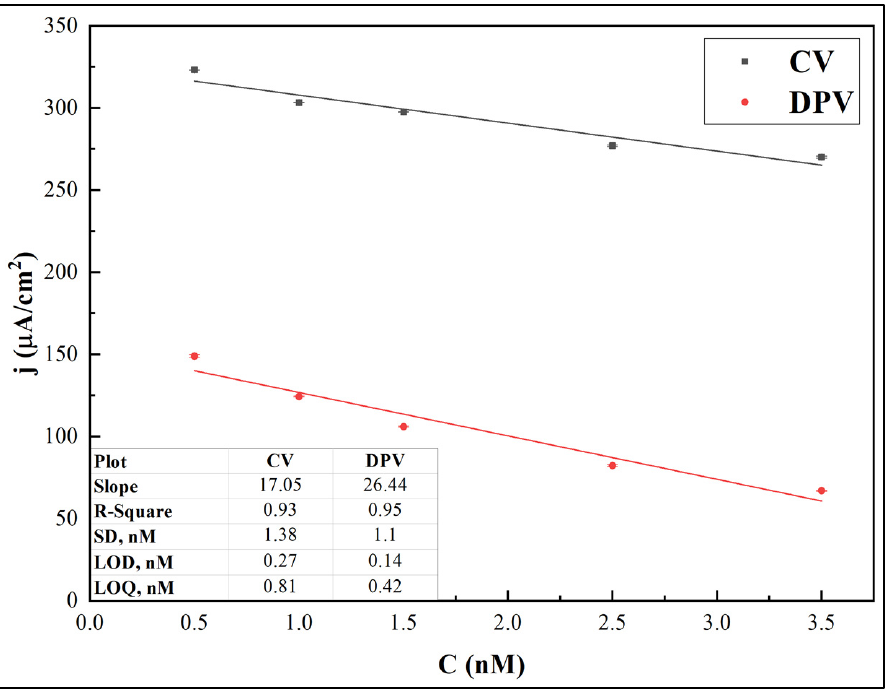
Figure 9. Calibration curves for j pa and j p obtained from CV and DPV peak values, respectively, vs. anti-rSpike antibody concentration. Error bars are calculated as a percentage of standard error. The LOD was calculated as 3.33 σ /s and LOQ was calculated as 10 σ /s, where σ is the standard deviation for the blank response and s is the slope of the calibration curve [42]. and 0.81 nM, respectively, while the values calculated from DPV data were 0.14 nM and 0.42 nM,